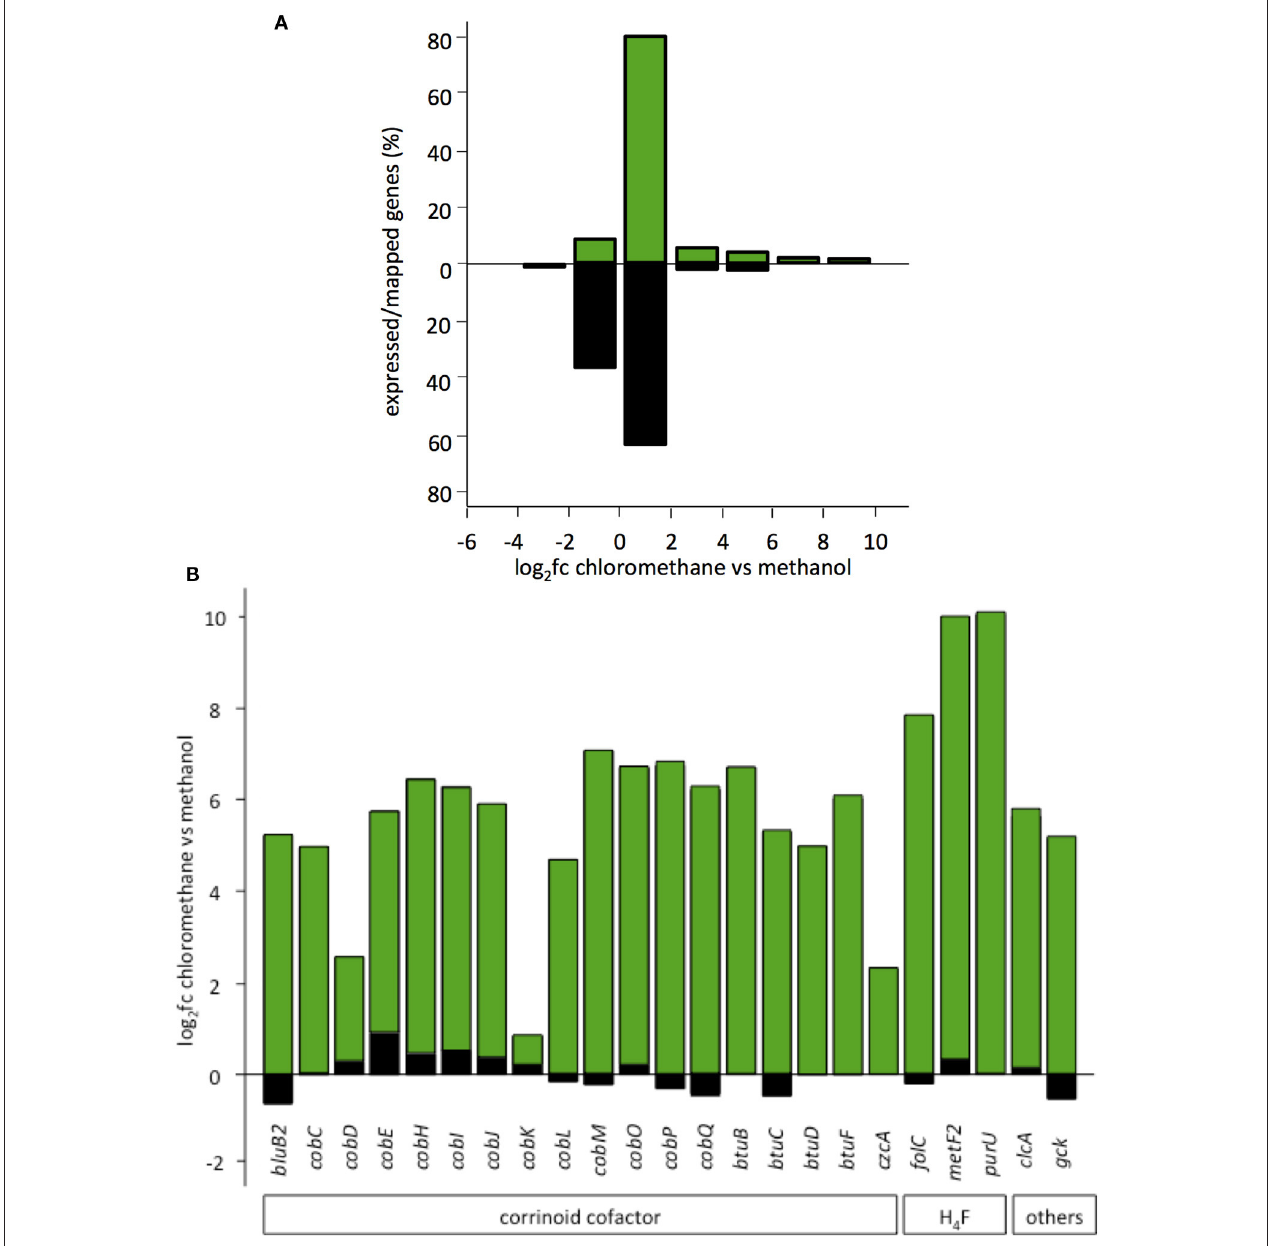
FIGURE 4 | Involvement of plasmid pCMU01 in the chloromethane transcriptome. (A) Expressed percentage of total genes per log 2 fc range. Genes encoded by plasmid pCMU01 (in green) and by the M. extorquens CM4 chromosome (in black) were grouped according to their log 2 fc values. Chromosome and plasmid pCMU01 encode 6,262 and 361 genes, and the total percentage of expressed genes is 1.4 and 17.5%, respectively. (B) Differential expression of pCMU01- and chromosome-encoded paralogs.